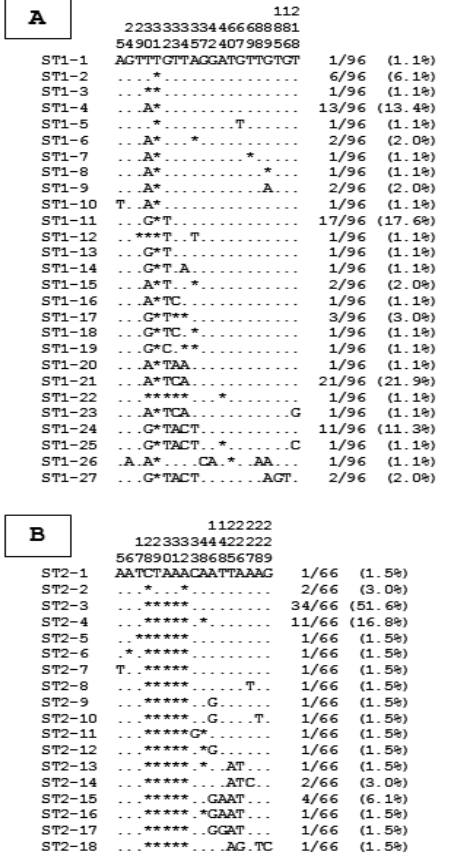
Figure 2. Alignment of partial SSU rDNA gene sequences from Blastocystis sp. ST1 ( A ), ST2 ( B ), and ST3 ( C ) isolates. Only the variable positions identified in the compared domain of the SSU rDNA gene for these three STs highlighted as largely predominant in the present survey are shown in this alignment. The positions of variable positions with respect to the reference sequences (genotypes ST1-1, ST2-1 and ST3-1) are indicated above the alignment (vertical numbering). Nucleotides identical to those of the reference sequences are represented by dashes and gaps are represented by asterisks. All the genotypes identified for each ST are indicated on the left of the alignment. On the right of the alignment are reported the total number and percentage of isolates identified in our study for each genotype.